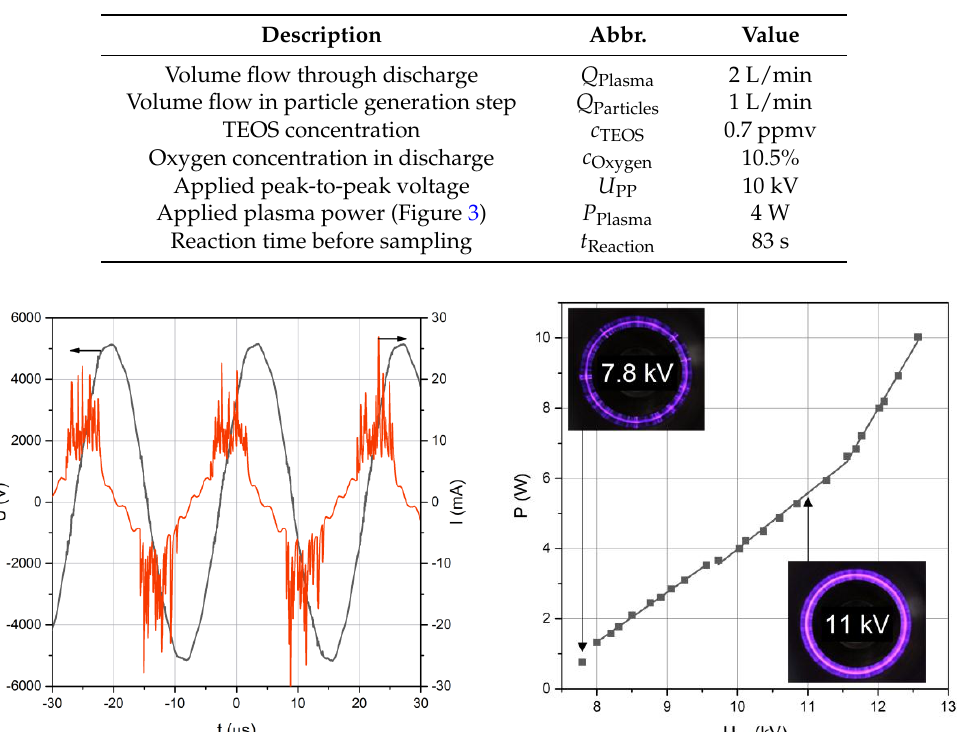
Figure 3. Temporal evolution of voltage and dielectric barrier discharge (DBD) current ( left ) and DBD power versus peak-to-peak voltage characteristic of the DBD with insets of violet light emitted from plasmas in air ( right